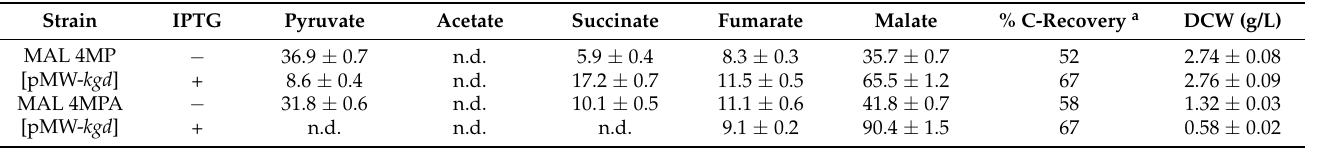
Table 3. Molar yields of metabolites produced by the MAL 4MP [pMW- kgd ] and MAL 4MPA [pMW- kgd ] strains during 19 h of aerobic glucose